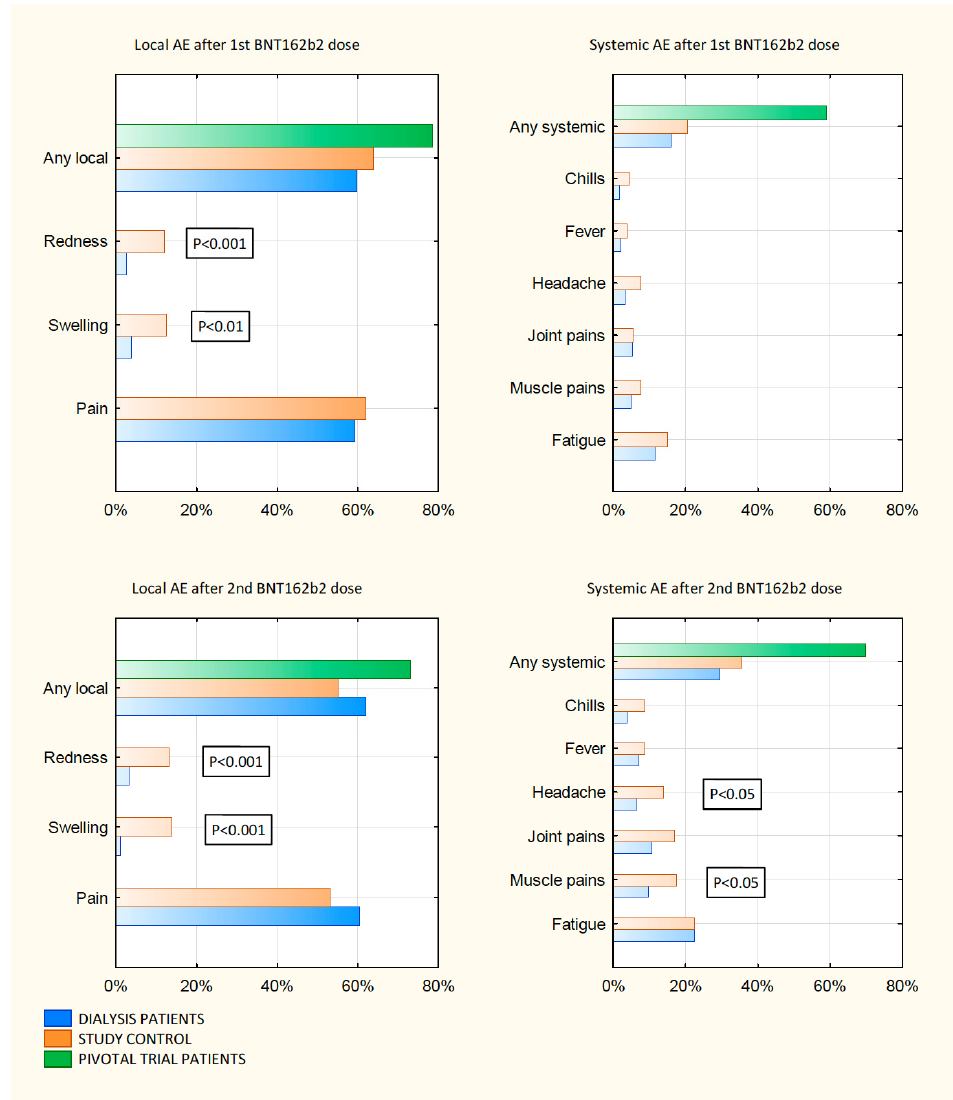
Figure 1. Local and systemic solicited adverse events after 1st and 2nd vaccine